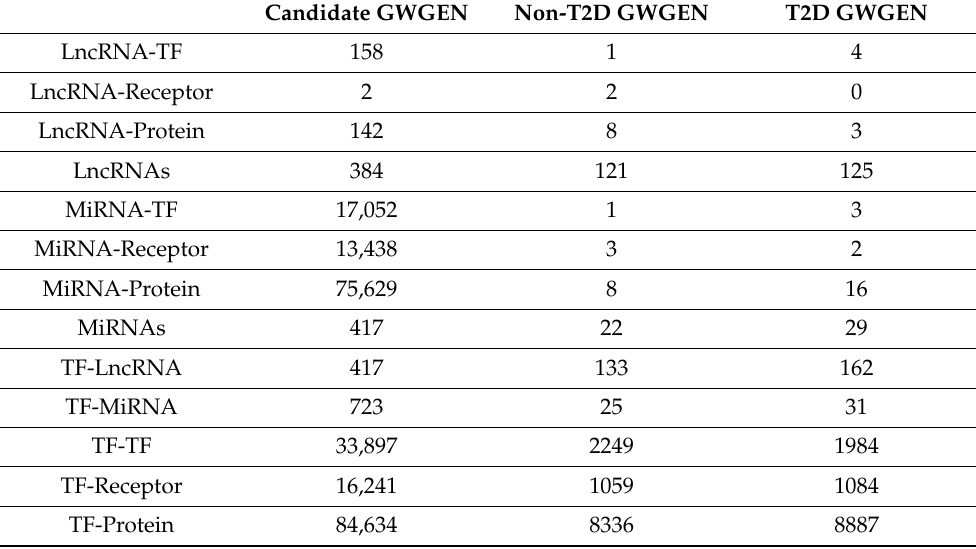
Table A1. The statistics of the nodes and edges in candidate GWGEN, non-T2D GWGEN, and T2D GWGEN after